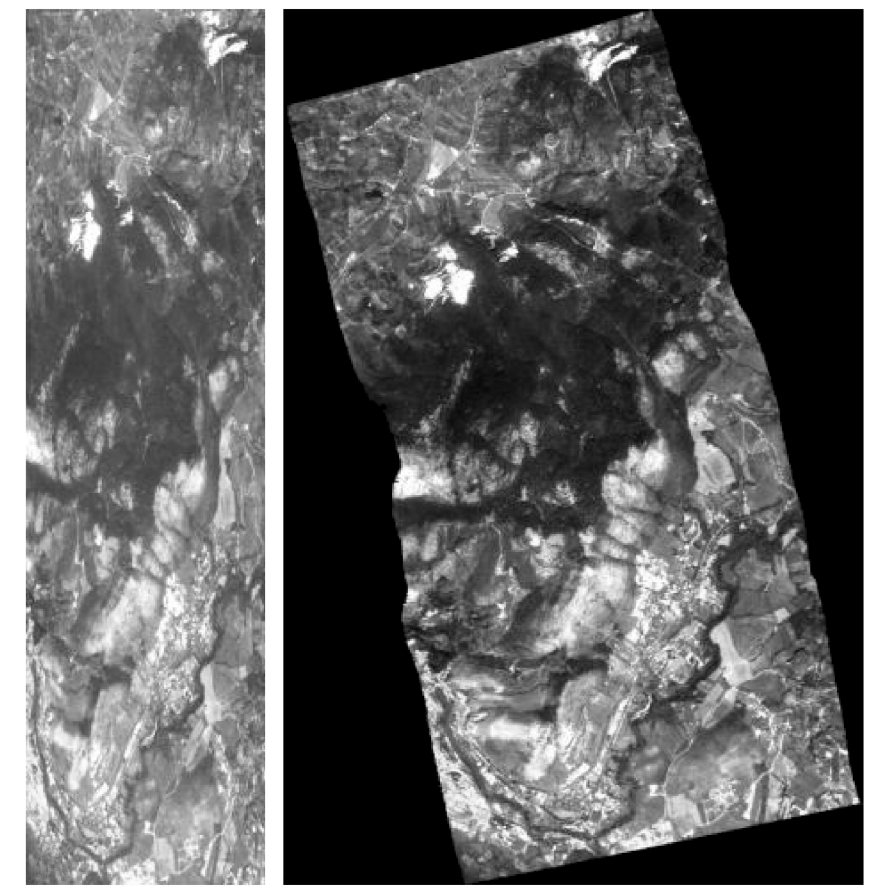
Fig. 3. Geometric correction: ( left ) uncorrected image; ( right ) geometrically corrected